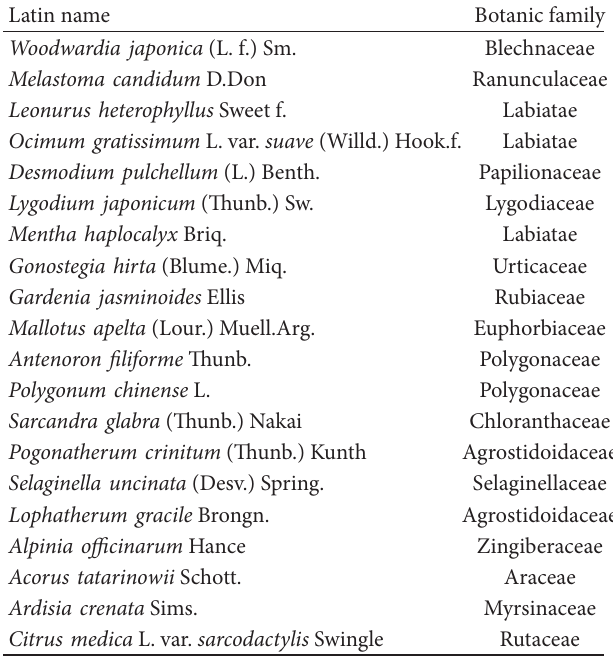
Table 1: The botanic families response to the 20 medicinal